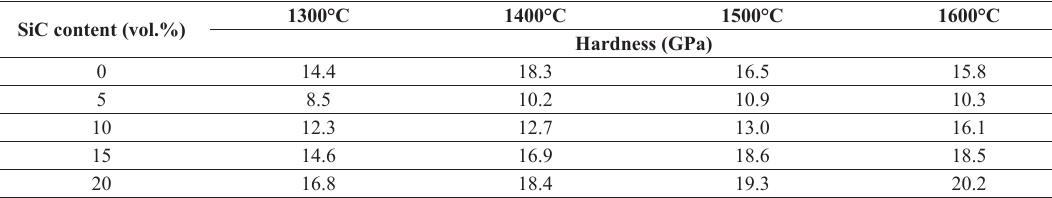
O -SiC composites sintered at 1600°C (a) 20vol.% SiC (b) 5vol.% SiC Figure 9: SEM images of Al 2 3 Table 2: Effect of SiC Reinforcement on Hardness of Sintered Composites SiC content